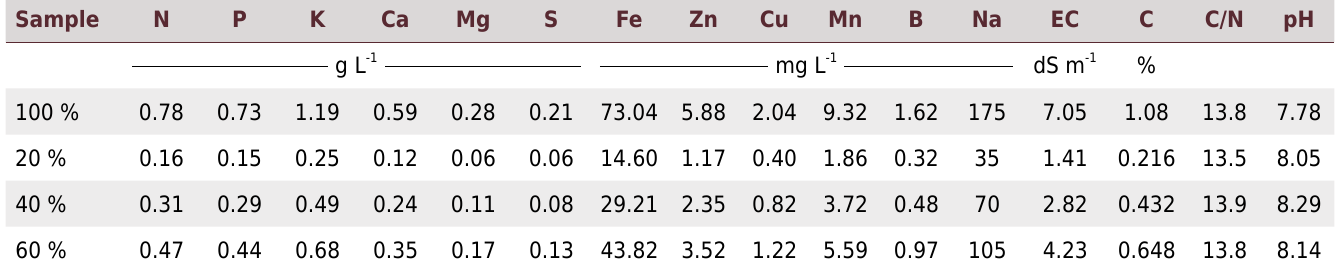
60 % 0.47 Fonte: Silva